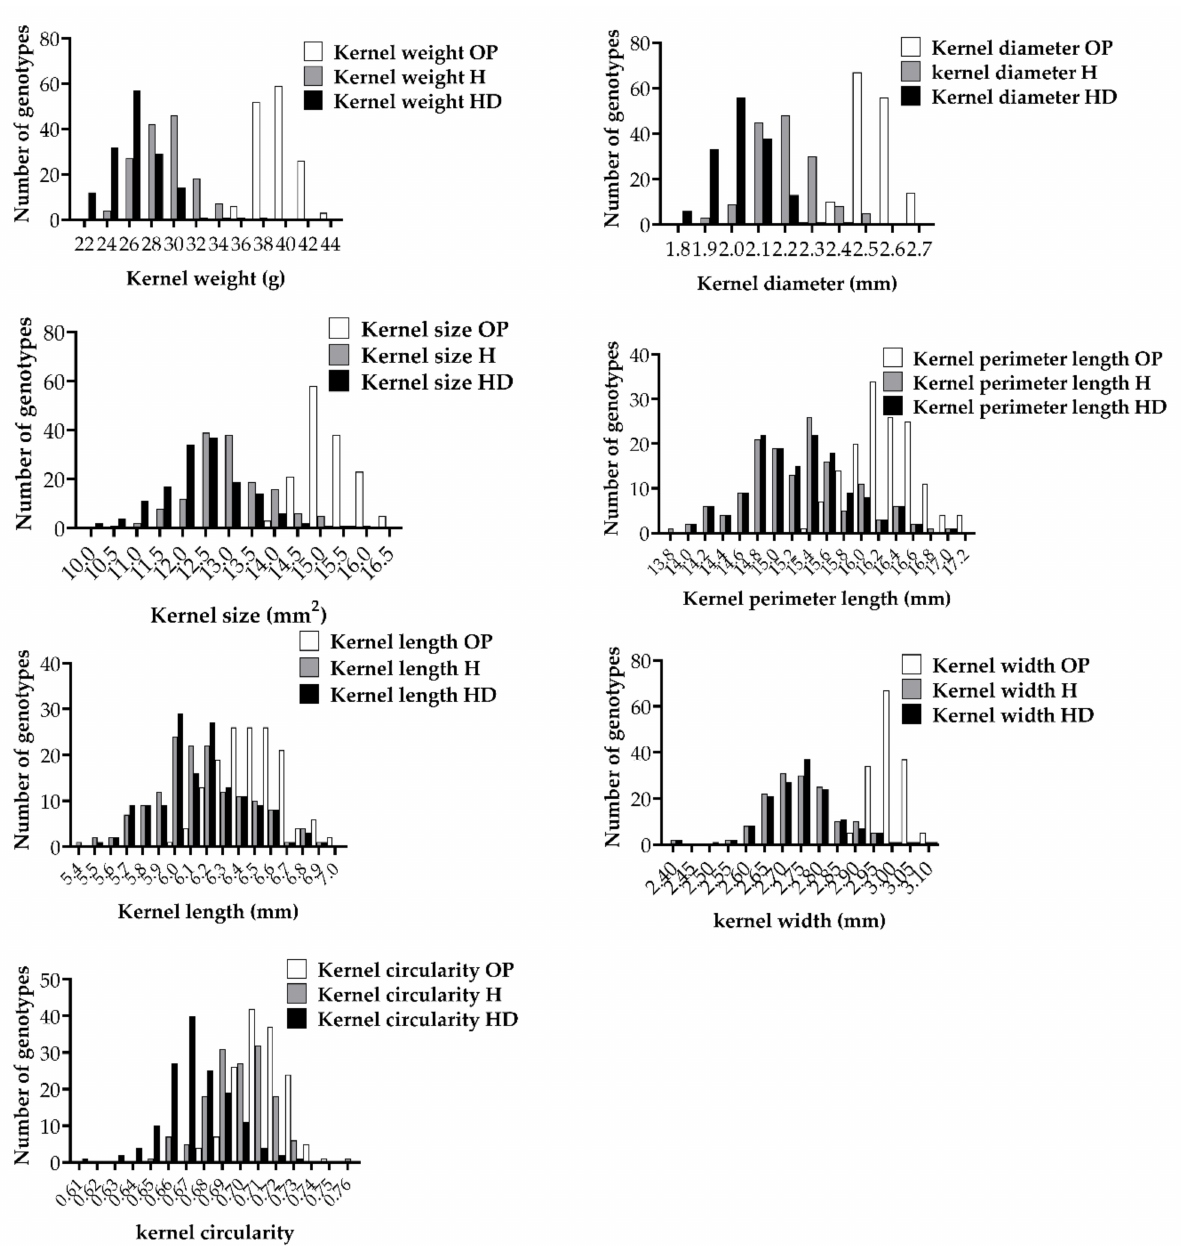
Figure 1. Frequency distribution of the multiple synthetic derivative lines grown under optimum (OP), heat (H) and combined heat–drought (HD) conditions. For the OP conditions, the predicted means of the values from two seasons, S1 and S2, were